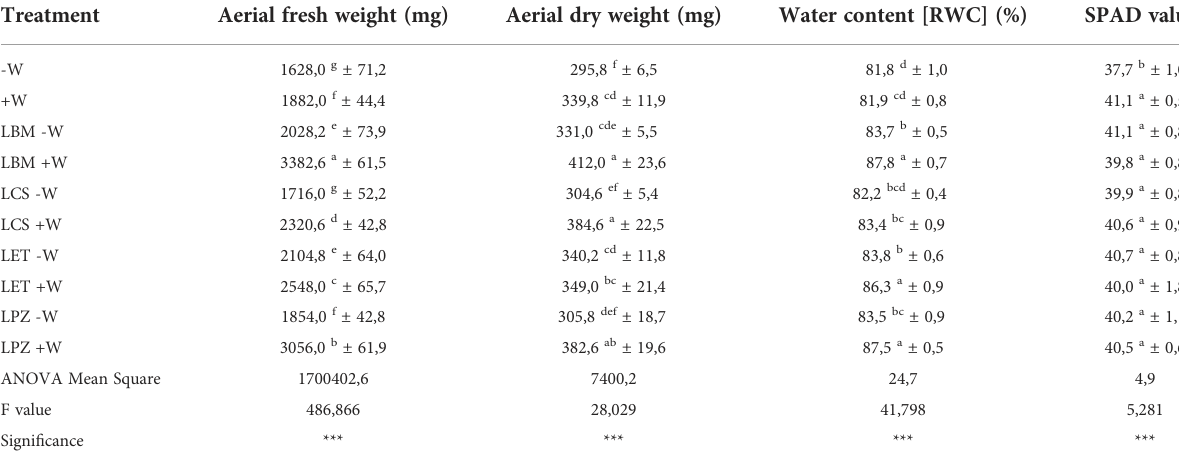
TABLE 2 Mean values and standard errors of aerial fresh and dry weight, RWC and SPAD values of wheat plants grown under drought stress vrs non-stress.